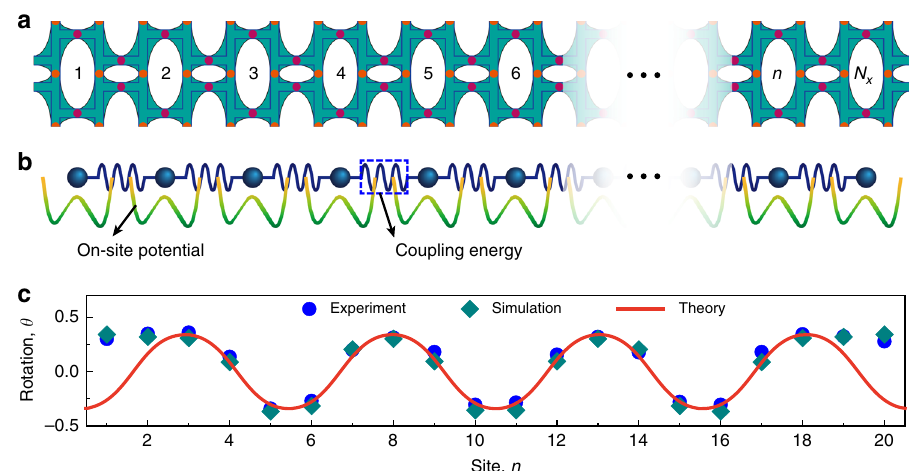
Fig. 3 One-dimensional model and the topological periodic-soliton solution. a One-dimensional mechanism model, the length of which underlies the design of the 1D cellular metamaterial chain. b A 1D particle chain interacting with a double-well potential serves as an equivalent, general physical model to reveal the formations of topological defects. The particle and coupling energy represent the unit cell, and the shear and bending between nearest cells, respectively. c The experimental and simulated rotation fi eld for a 20 ´ 3 specimen at a strain ε ¼ 10 : 7 % is predicted by the φ 4 topological periodic-soliton